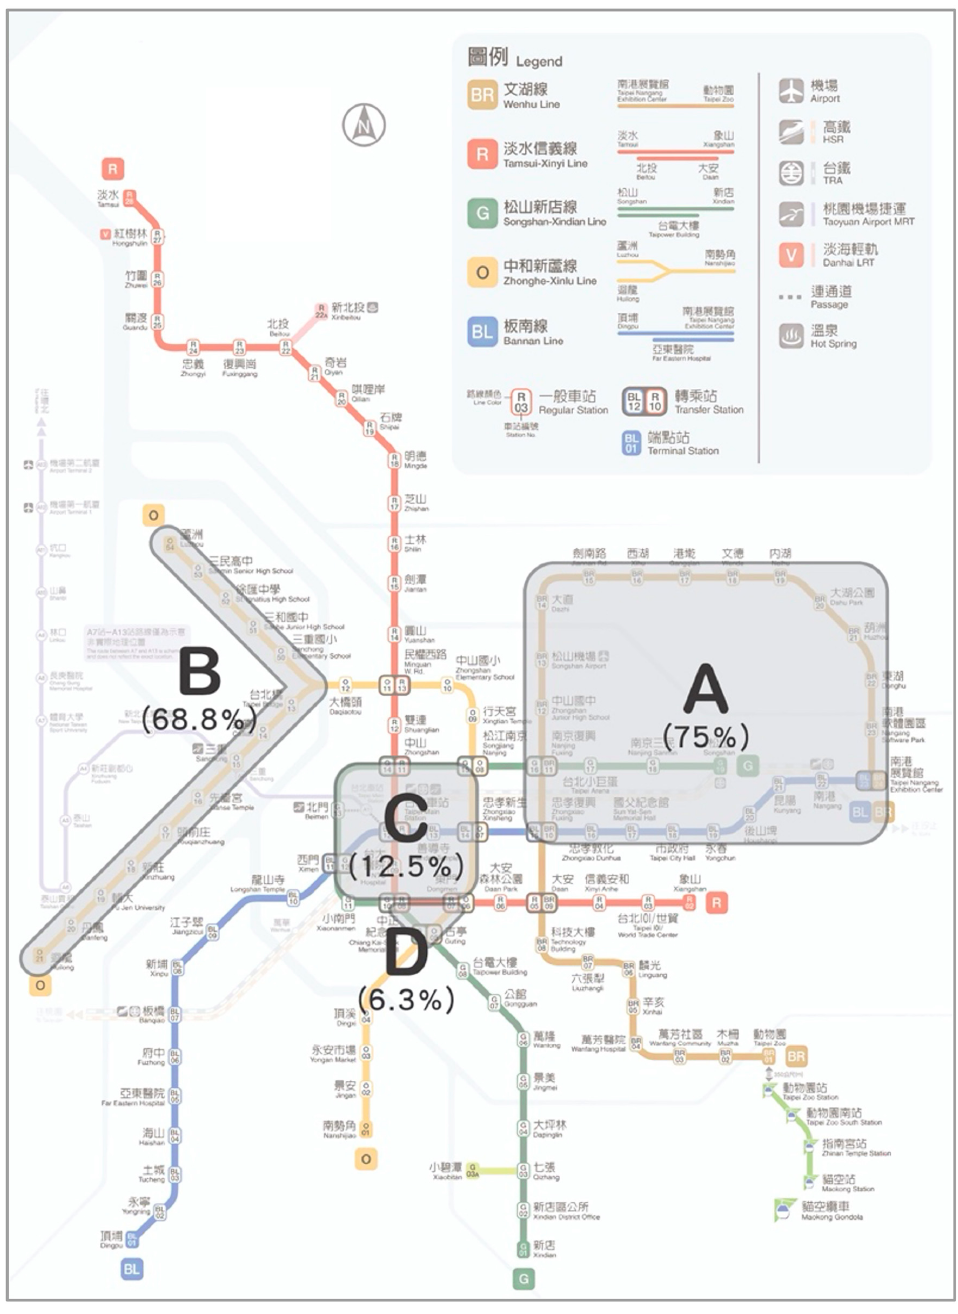
Figure 4. Graphic memory usage percentage in terms of drawing elements.